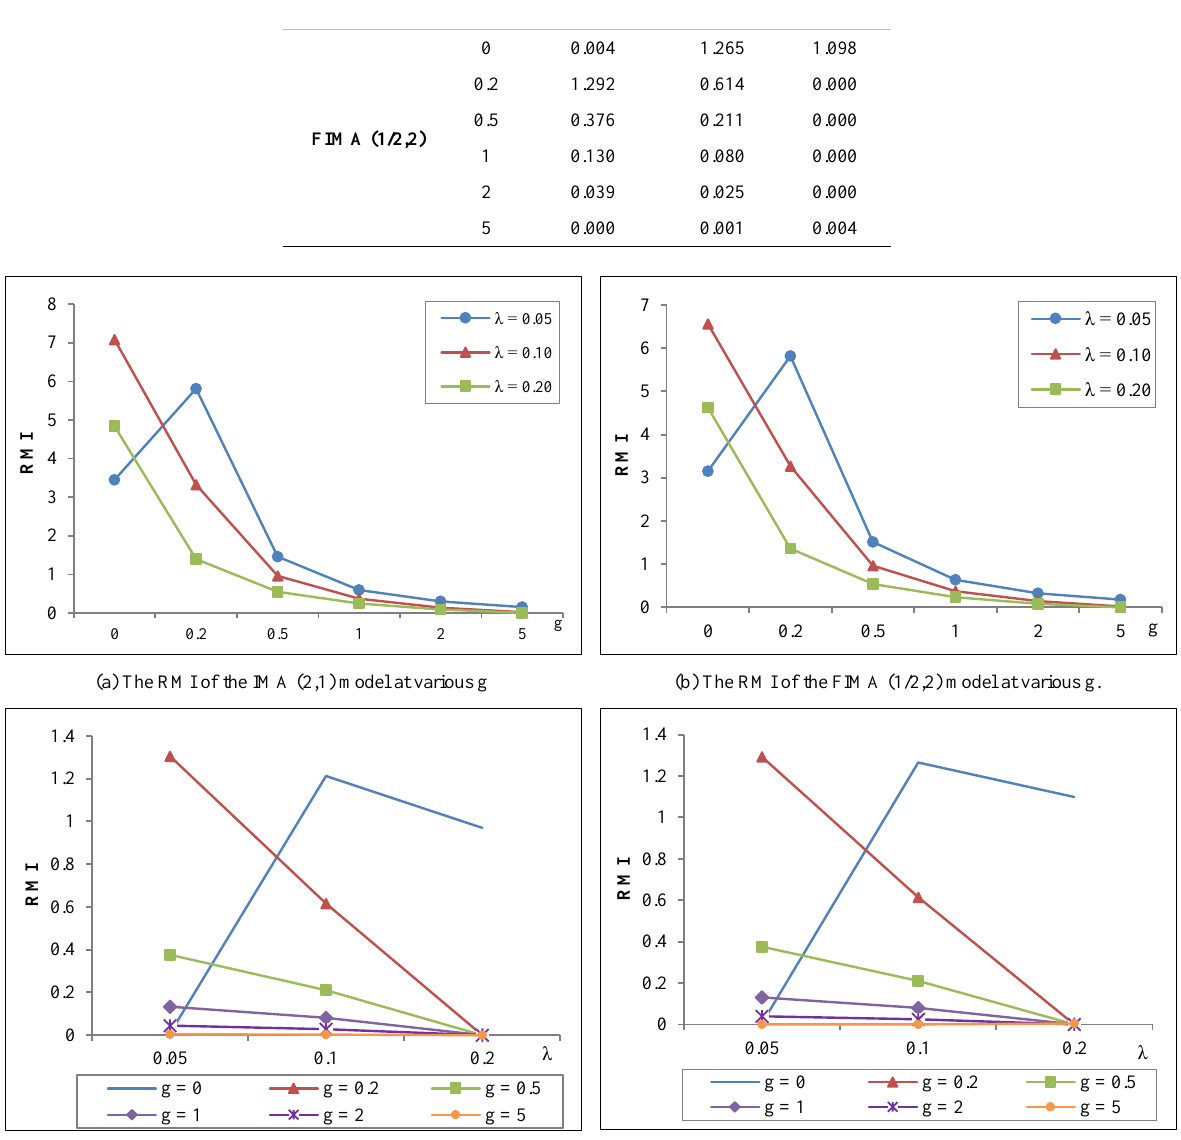
Figure 2. The RMI of two models at various